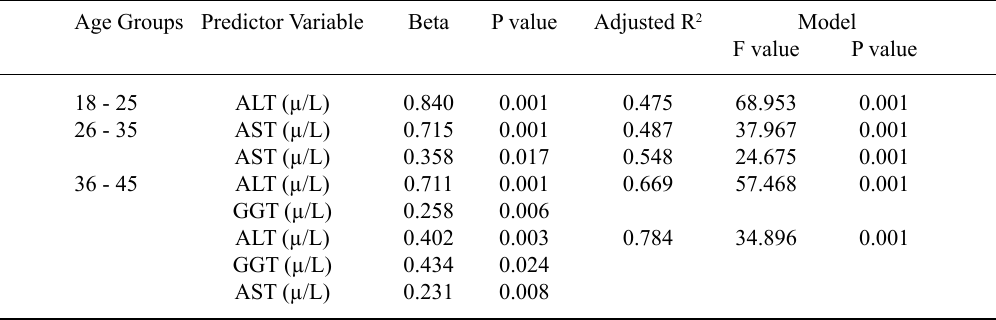
Table 5. Multiple regression using stepwise method for IgM as a dependent variable age groups Predictor